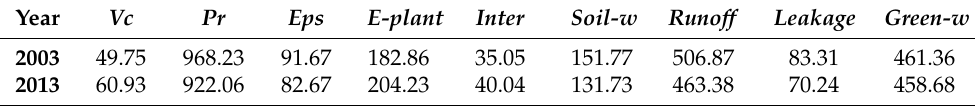
Table 4. Component values of blue water and green water in 2003 and 2013.